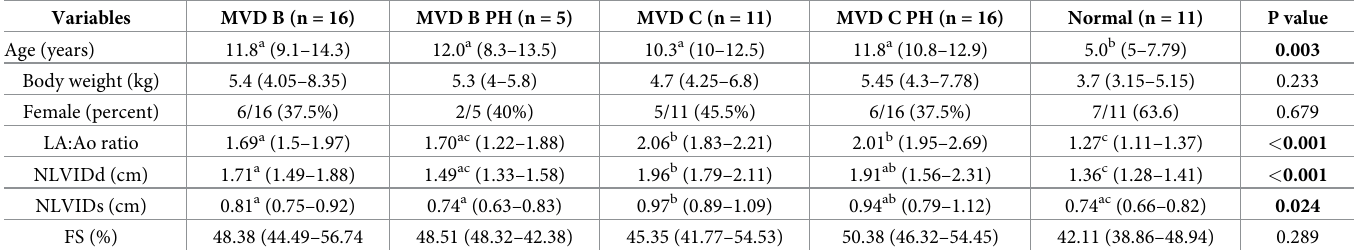
Table 1. Baseline characteristics of the 59 dogs in all